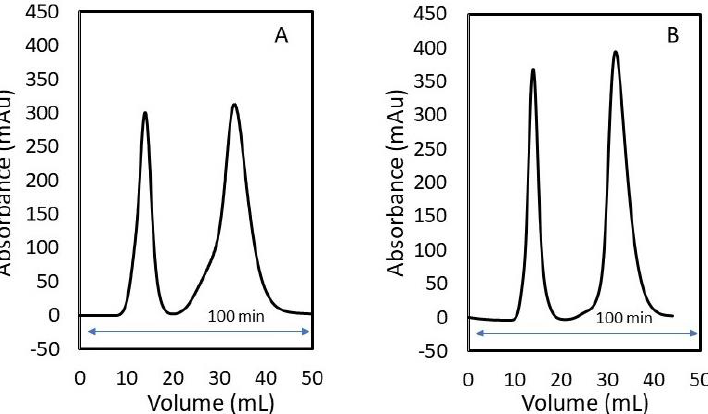
Figure 5. Chromatograms obtained during BSA (5 mg/mL) and lysozyme (2.5 mg/mL) separation using ( A ) the conventional (Tricorn GL 10/300) column and ( B ) the 24 mL z 2 cuboid SEC device (medium: Sephacryl S-200 HR; mobile phase: phosphate-buffered saline (pH 7.4); flow rate: 0.5 mL/min; loop size: 2 mL).